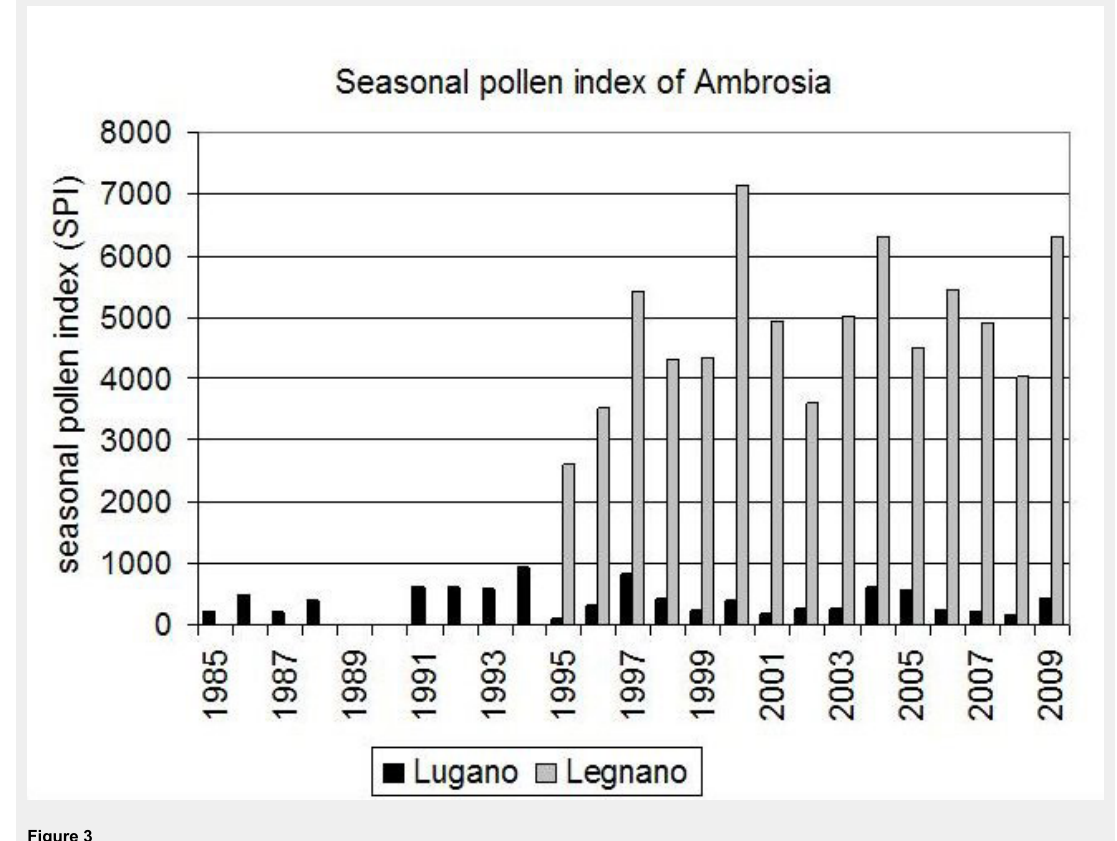
Figure 3 Seasonal pollen index (sum of daily concentrations from July-October) in Legnano (I) and Lugano (CH).